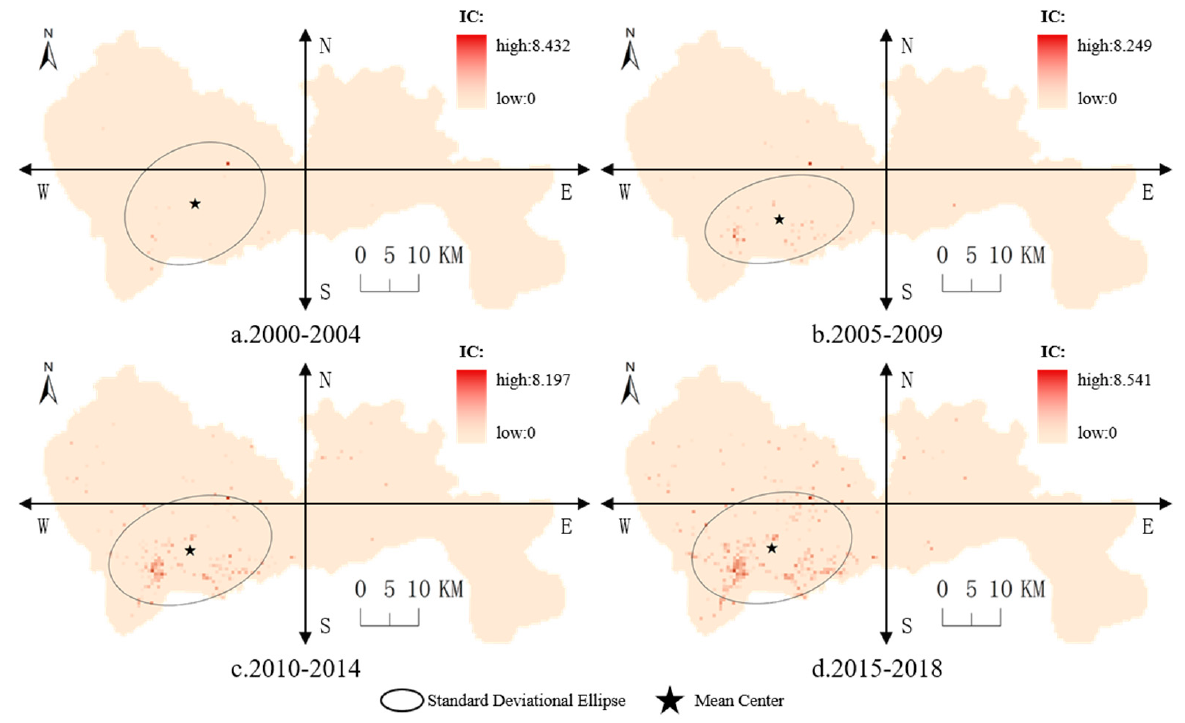
Figure 7. Spatial distribution of the innovation capacity of the tertiary industry in Shenzhen.